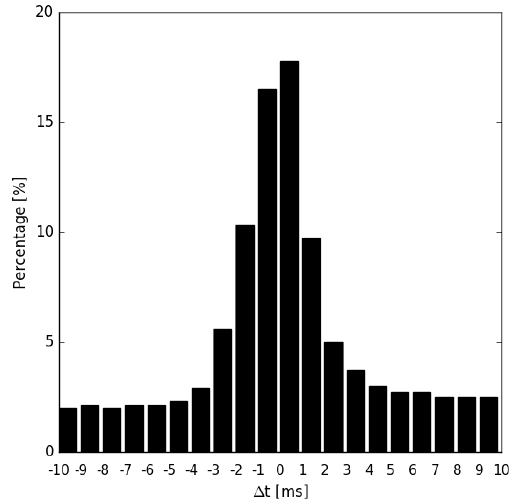
Figure 5. Time offset, t ISS-LIS − t EUCLID , between matched ISS- LIS groups and EUCLID strokes and pulses. A positive (negative) value indicates that the ISS-LIS group occurred later (earlier) than the matched EUCLID stroke/pulse.